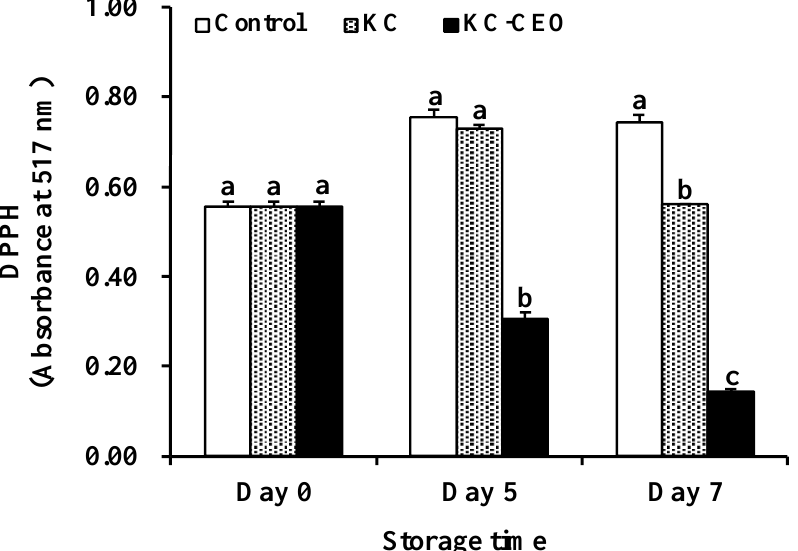
Figure 4. Impact of KC-based coatings on the DPPH scavenging activity of pork meat during refrigerated storage (4 ◦ C). KC, kappa-carrageenan; CEO, cinnamon essential oil. Different letters for data points on each day represent significant differences ( p < 0.05).